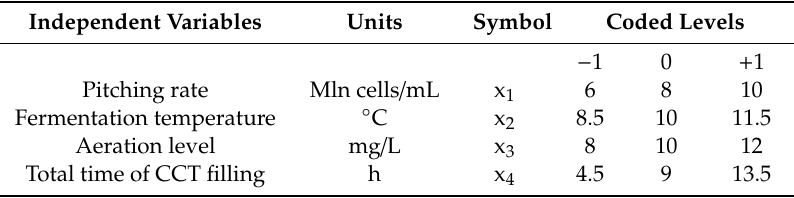
Table 1. Coded and actual values of the variables for the Box–Behenken design. Independent